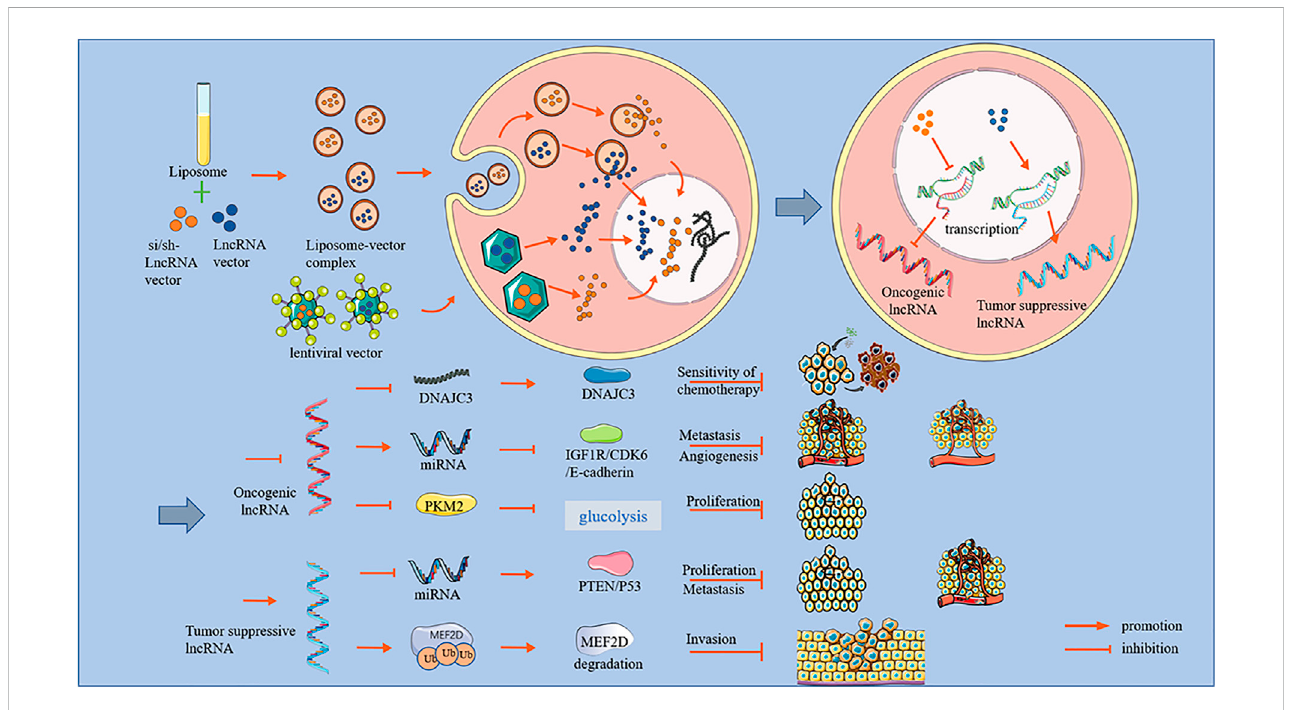
FIGURE 1 An overview of lncRNA effects and